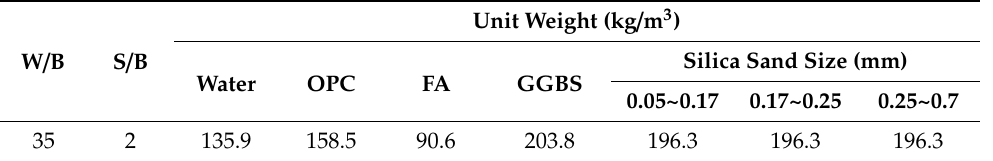
Table 1. Mix proportions for mortar.